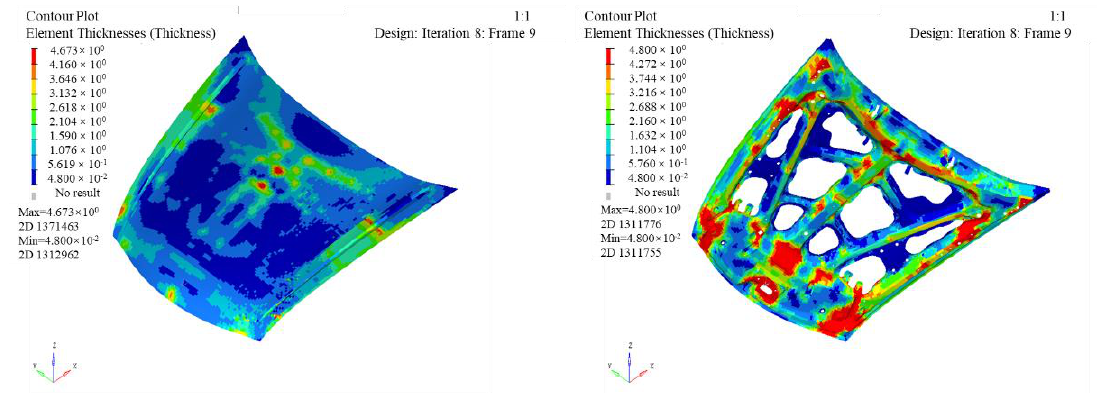
Figure 8. Cloud map of inner and outer panel thickness after optimization of ply cut shape.